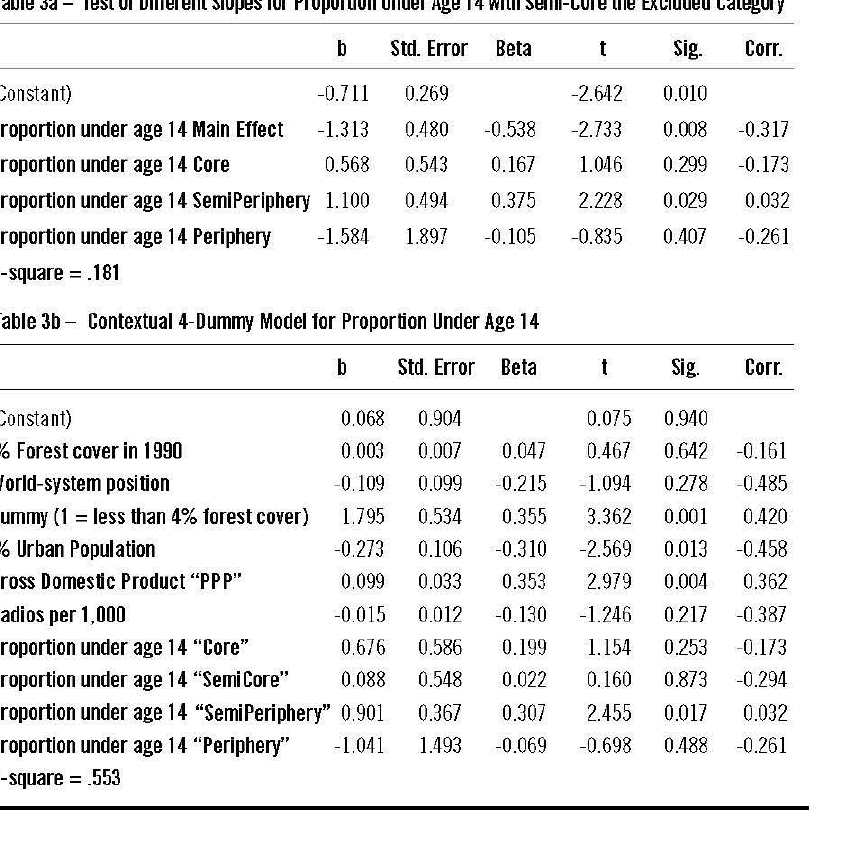
Table 3 - World-System Position by Population Under Age 14 Interactions Table 3a - Test of Different Slopes for Proportion Under Age 14 with Semi-Core the Excluded Category b